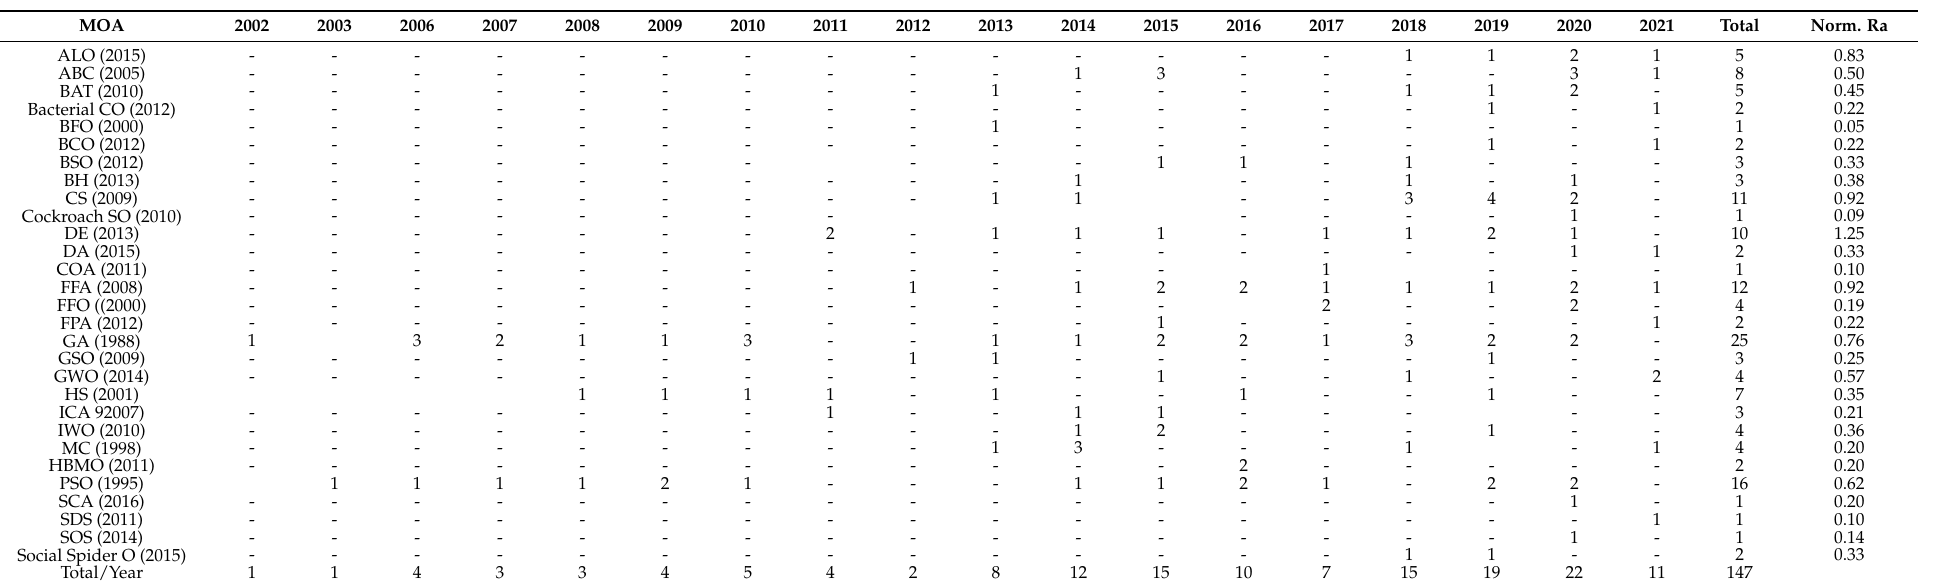
Table 3. The year-wise bifurcated K-means hybridization with MOA Publication